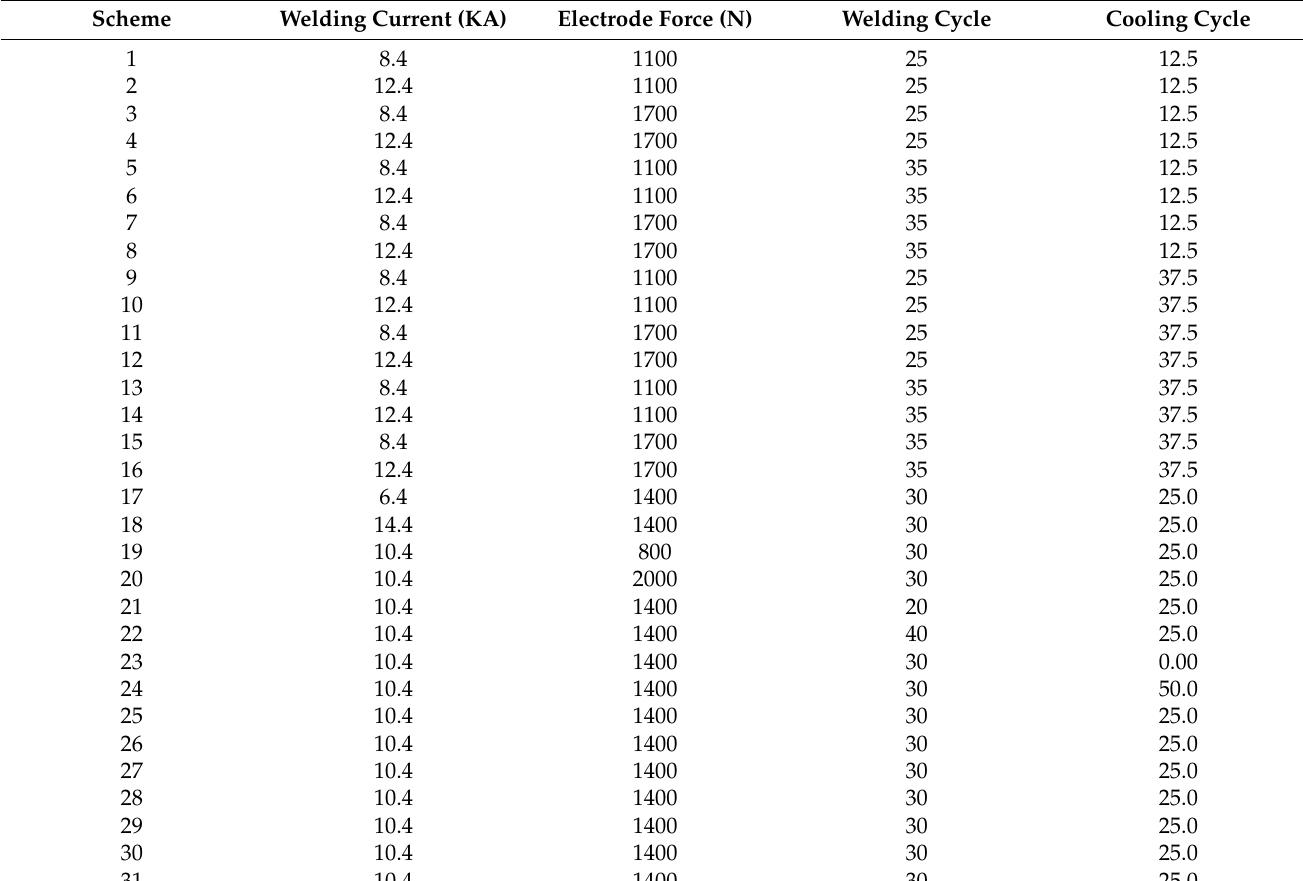
Table 3. Design layout of RSW experiments based on response surface methodology.